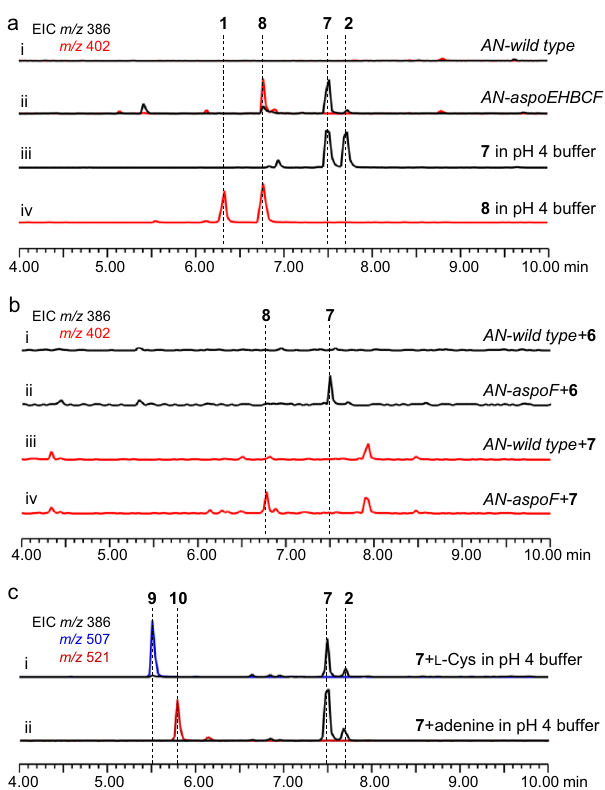
Fig. 4 Con fi rmation of the function of the aspoF gene and the nonenzymatic conversions towards 7 and 8. a LC-MS analyses of the culture extracts from the A. nidulans transformants and the products from 7 and 8 conversion under acidic conditions. b Chemical feedings con fi rmed that AspoF catalyses only successive hydroxylation reactions to form 7 and 8 . c Mimic synthesis of mero-cytochalasans via Michael addition using 7 as the example substrate. The EICs were extracted at m/z 386 [M + H] + for 7 and 2 , m/z 402 [M + H] + for 8 and 1 , m/z 507 [M + H] + for 9 , and m/z 521 [M + H] + for 10